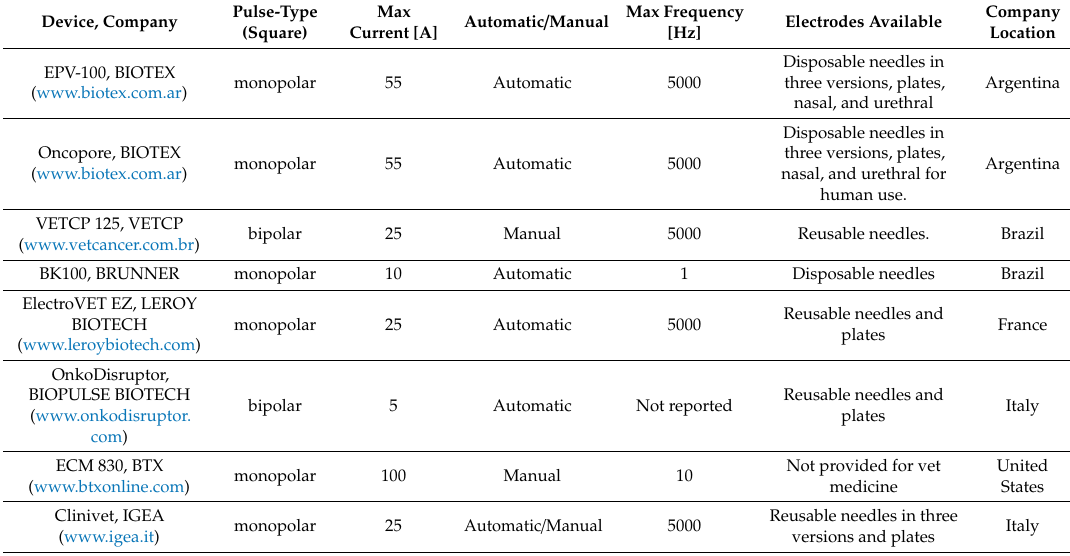
Table 3. Commercially available electroporators in Latin America.